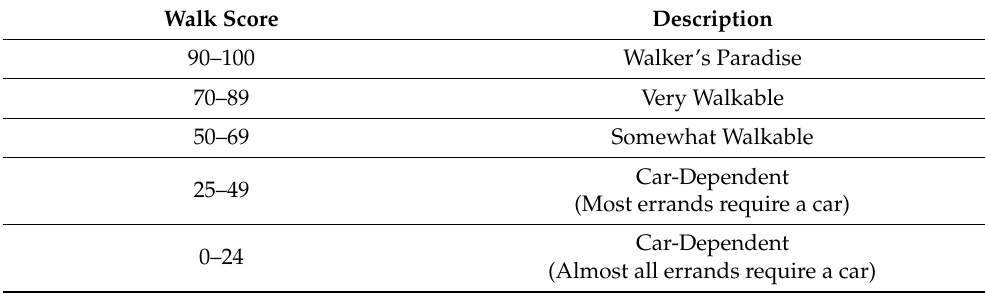
Table 2. The walkability score using a patented system. Source: Adapted by the researchers retrieved from